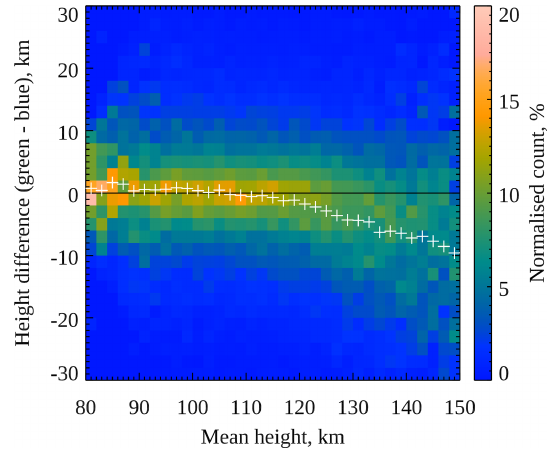
Figure 4. Two-dimensional histogram of auroral peak emission height observations binned according to the difference between green and blue heights (ordinate, positive values indicating green height above blue height) and mean (i.e. midpoint) of the simulta- neous green and blue heights (abscissa). The shading represents the number of observations in each bin, normalised to the total number of observations in each column, according to the colour bar scale. The mean height difference for each column is shown as a white plus symbol.